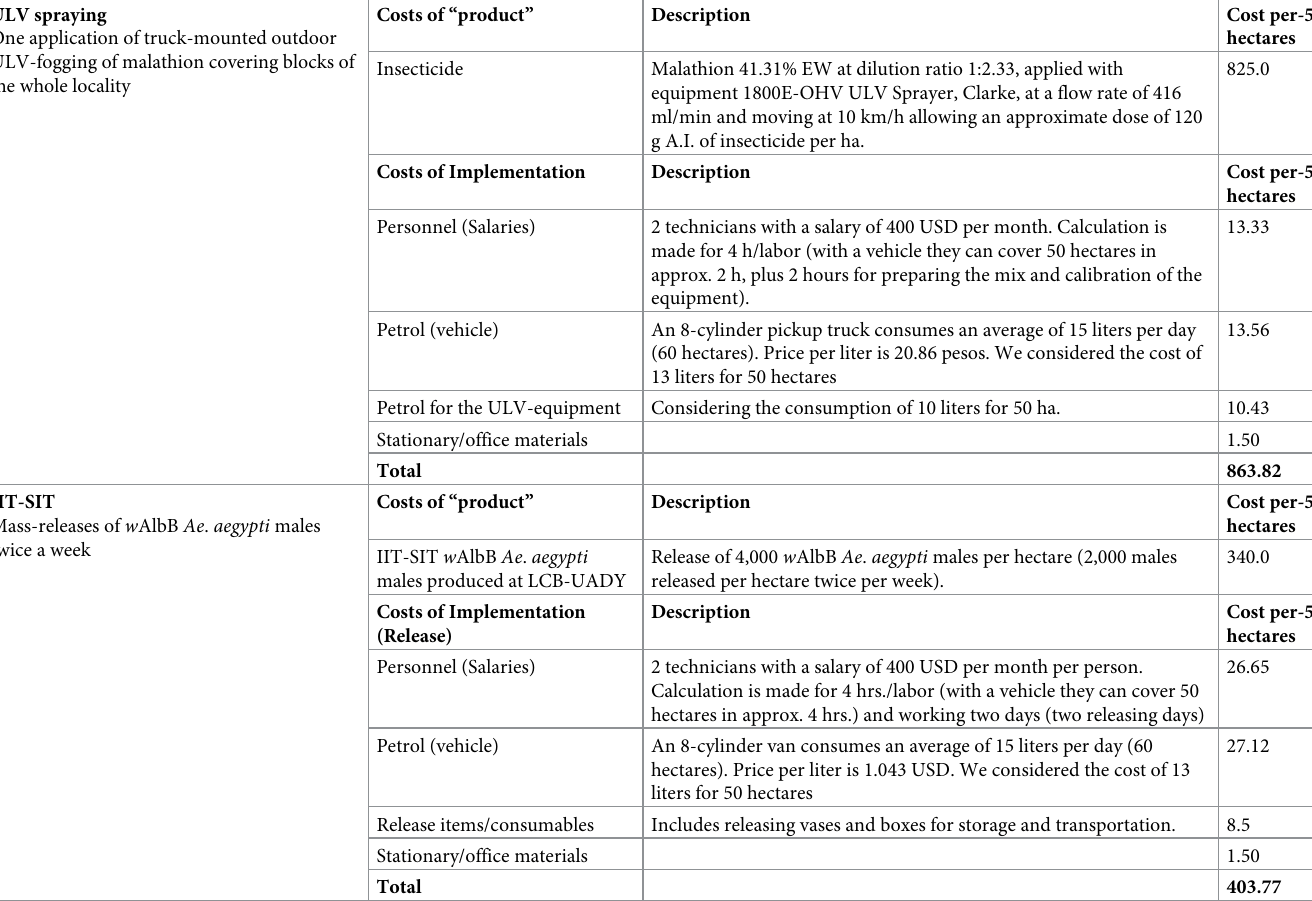
Table 2. Cost estimates table (USD) for the implementation of ULV spraying and release of IIT-SIT w AlbB males identified for an area of 50 ha v . gr . San Pedro Chimay. ULV spraying One application of truck-mounted